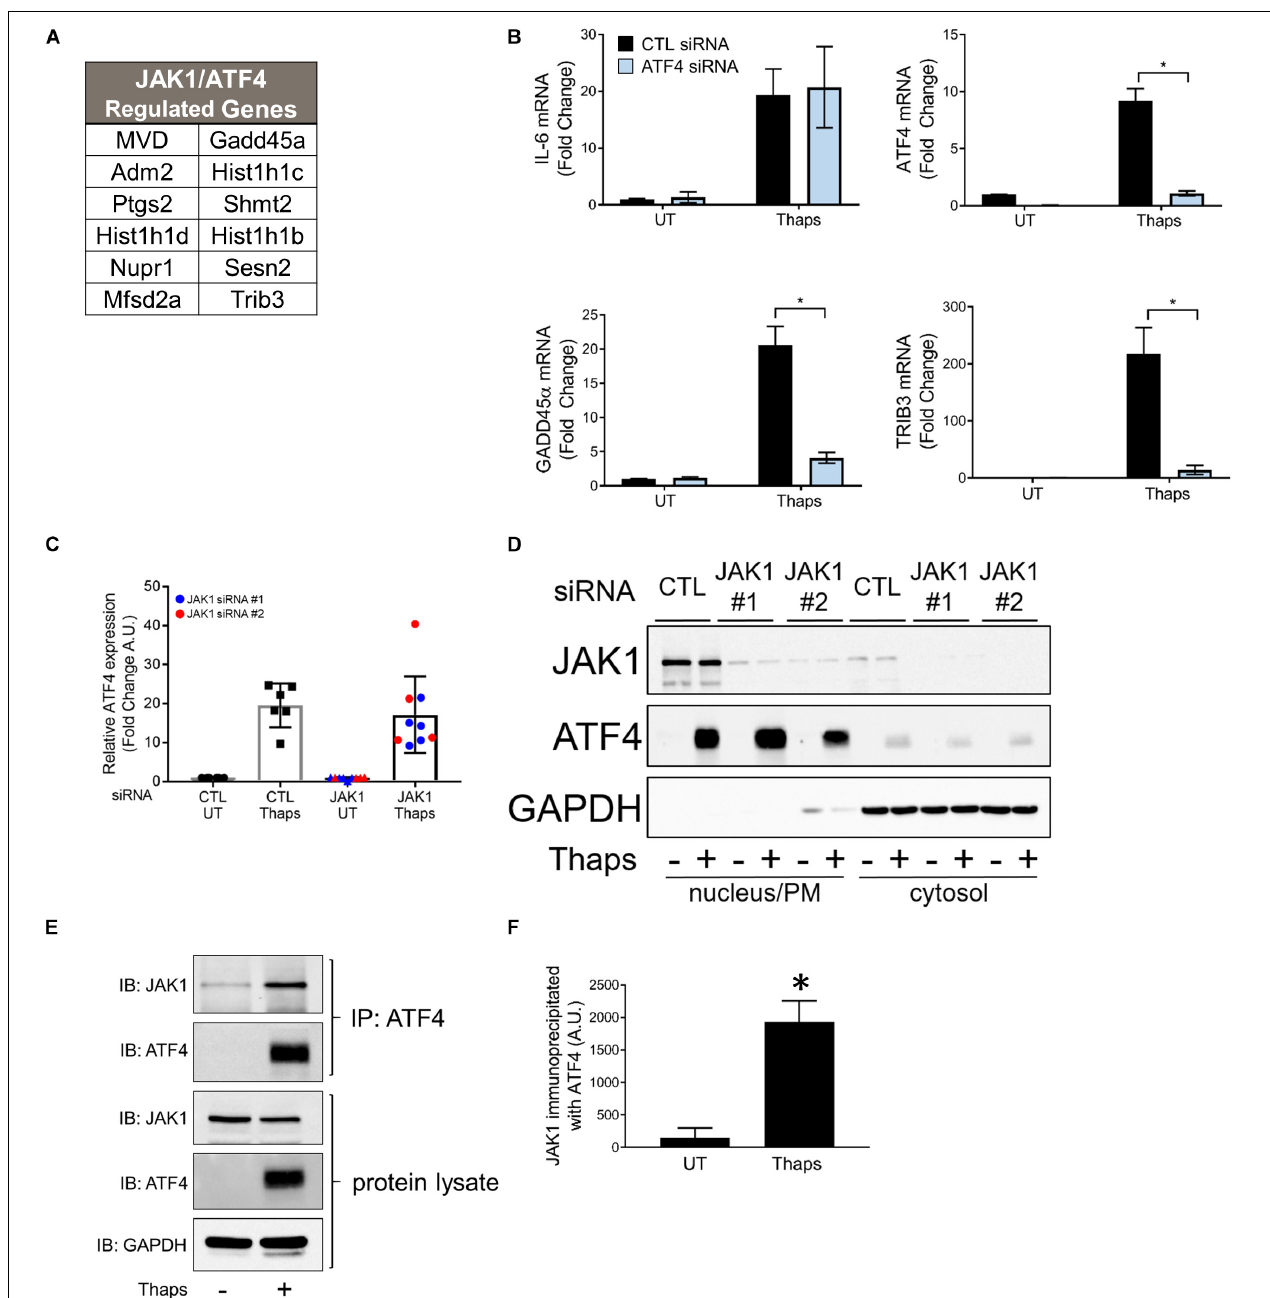
FIGURE 5 | JAK1 and ATF4 cooperatively regulate a subset of ER stress-induced genes. (A) List of genes that are both JAK1 and ATF4 dependent in response to ER stress as determined by RNA-seq and reported by others. (B) Astrocytes were transfected with control (CTL) or ATF4-targeting siRNA for 48 h and treated with thapsigargin for 4 h. Indicated gene expression was analyzed by RT-qPCR. UT = untreated. (C) Astrocytes were transfected with CLT or one of two JAK1 siRNAs and immunoblotted for ATF4. Immunoblots were quantified and normalized to GAPDH expression. (D) Astrocytes were transfected with CTL or JAK1 siRNA for 48 h and then treated with thapsigargin for 4 h. Cytosolic and nuclear fractions were isolated and analyzed by immunoblot. (E) Primary astrocytes were treated with thaps (1 µ M) for 4 h. Protein lysates reserved or immunoprecipiated with α -ATF4 antibody before immunoblotting. (F) Quantification of JAK1 co-immunoprecipiated with ATF4 as shown in the top panel of (E). Data are represented as means ± standard deviation. N = 3. ∗ p ≤ 0.05.